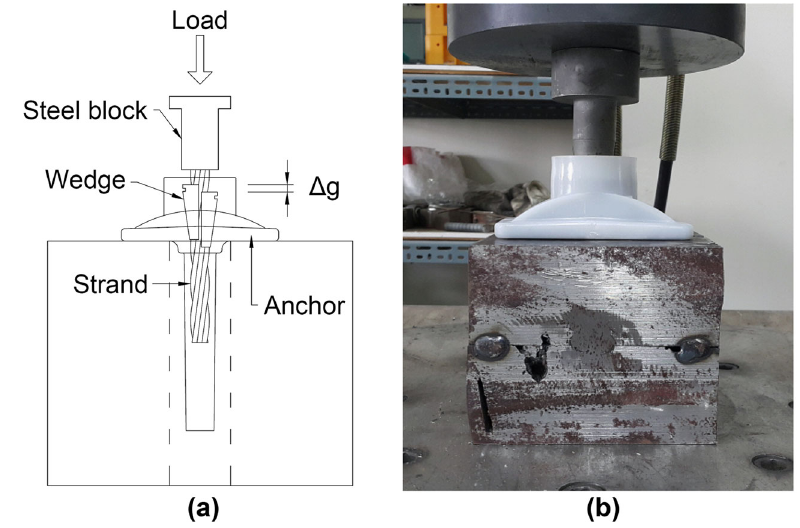
Fig. 5 Setup for push-in test. a Section view and b test